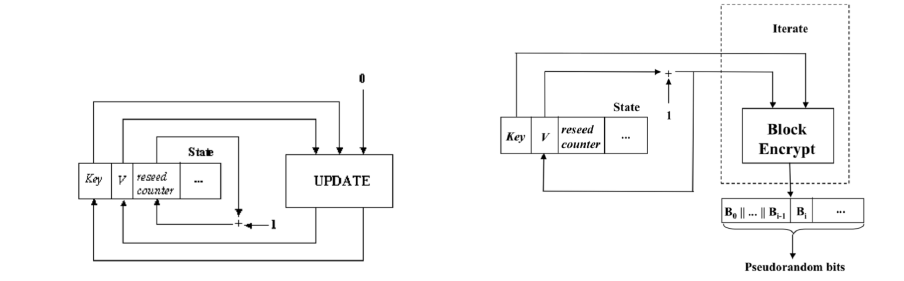
Figure 3: Operation of the NIST CTR_DRBG _Update function (left) and random bit stream generation (right) [BK15]